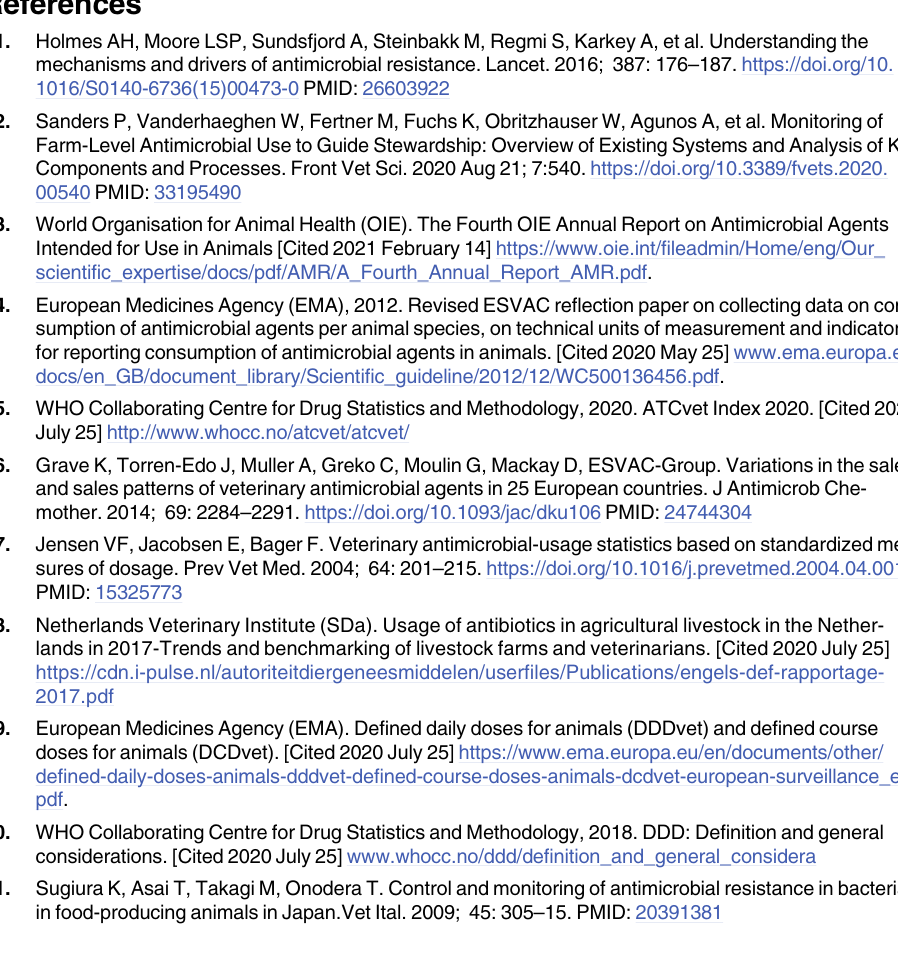
S3 Table. Japanese DDD values (DDDjp) defined in this study for antimicrobial agents used in poultry in Japan and corresponding DDD values (DDDvet) defined by the Euro- pean Medicines